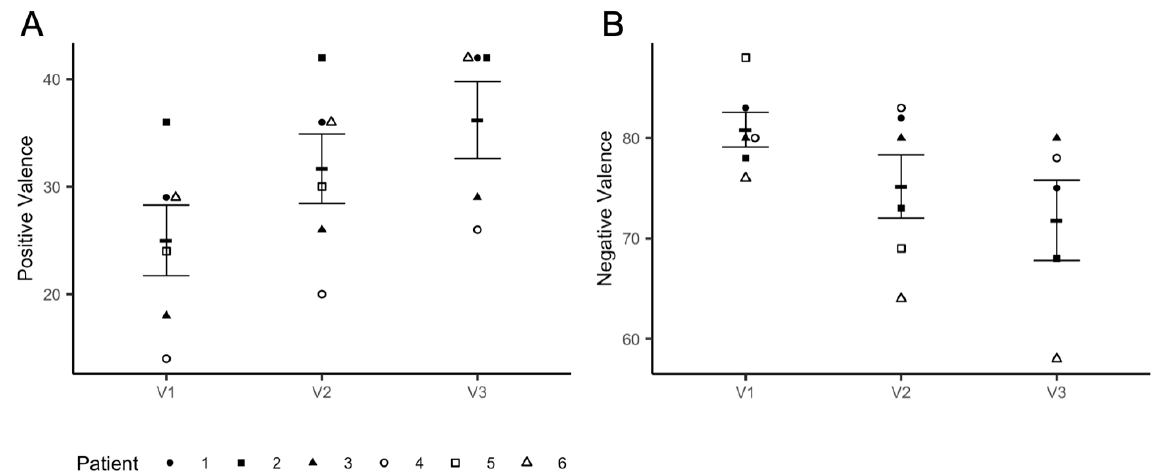
Figure 4. Changes in valence levels. Panel ( A ) shows an increase in positive valence ratings from Visit 1(V1) to Visit 3 (V3); panel ( B ) shows a decrease in valence ratings in response to fearful faces from V1 to V3. Participants received iTBS (3 daily session) on V2 and V3.